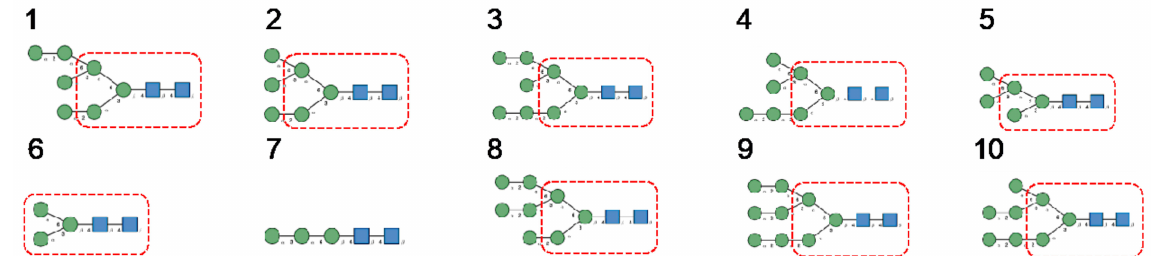
Figure 21. Glycans recognized by ESA-2 in glycan-binding activity measurements, arranged from 1 to 10 in decreasing order of affinity.